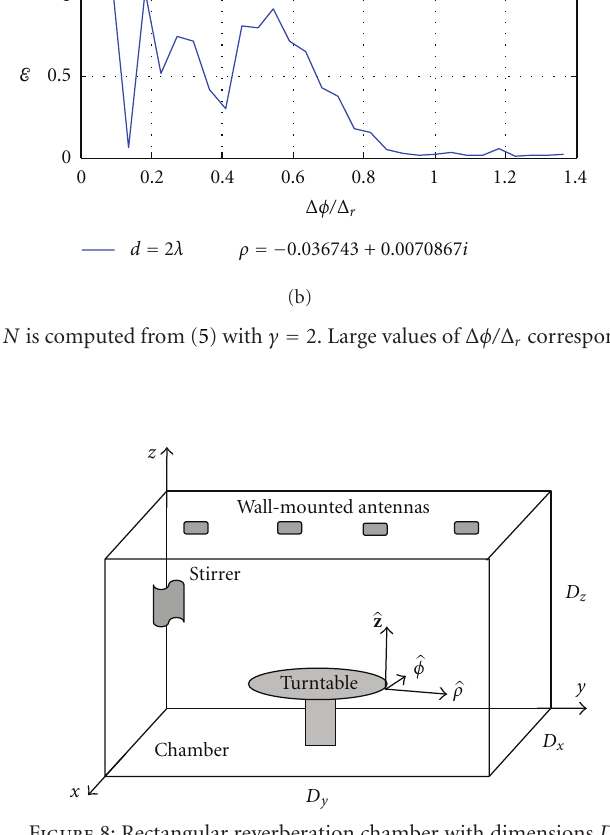
Figure 8. The dyadic Green’s function (field due to a